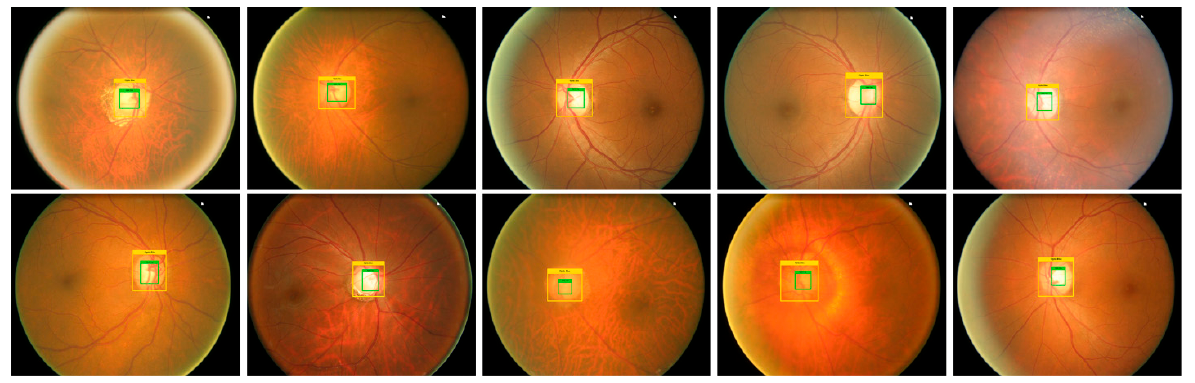
Figure 3. Annotation